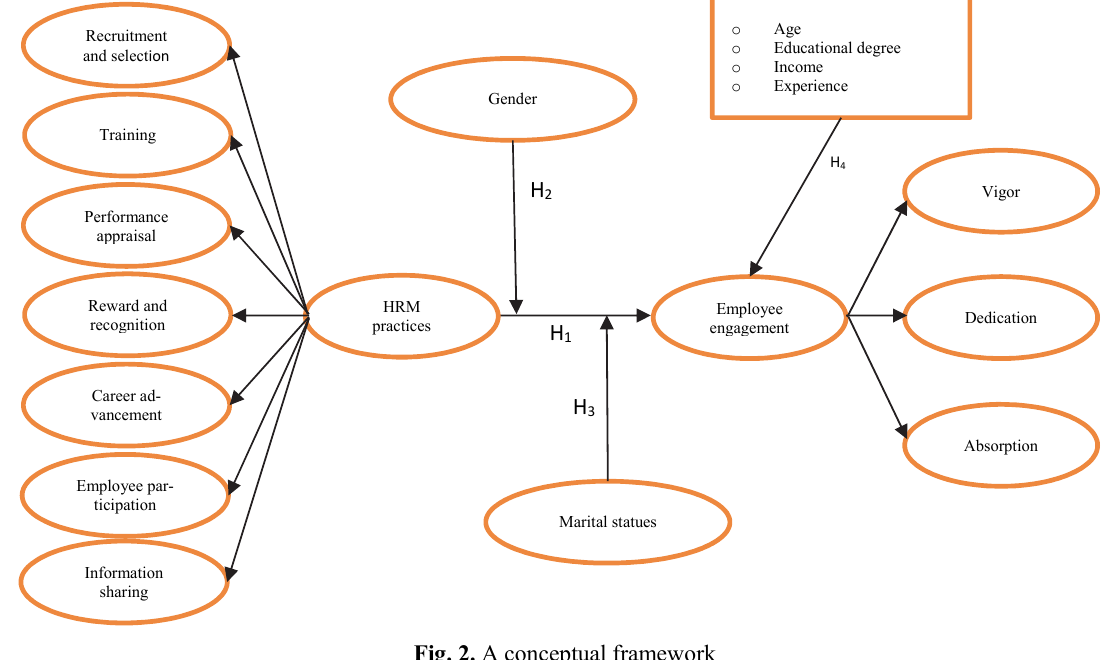
Fig. 2. A conceptual framework Control